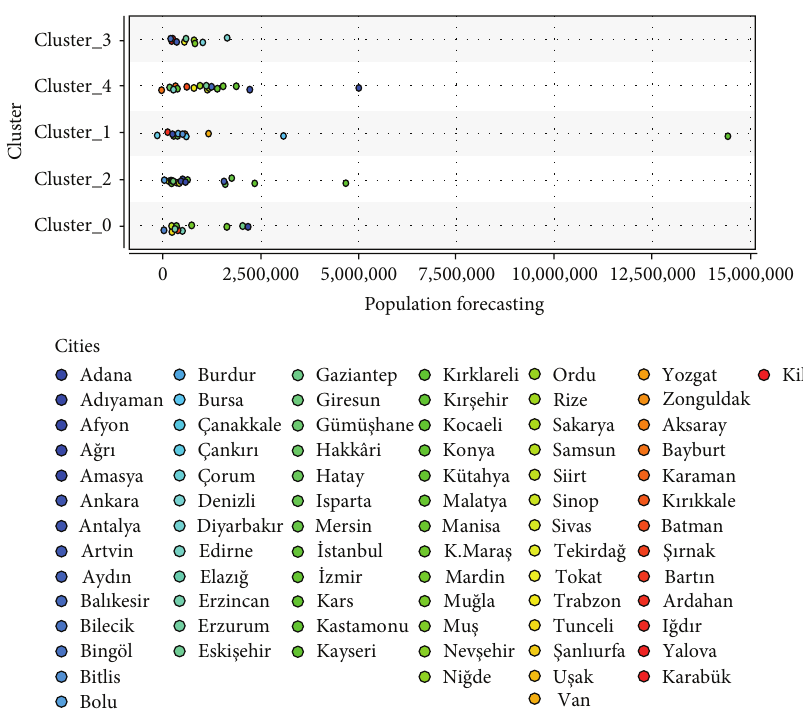
Figure 4: Clustering results according to population forecasting.